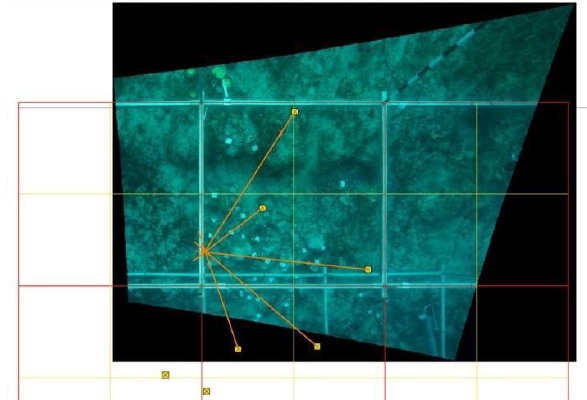
Figure 5. Identification of the camera projection center on the rectified image (data processing: S. Caressa).